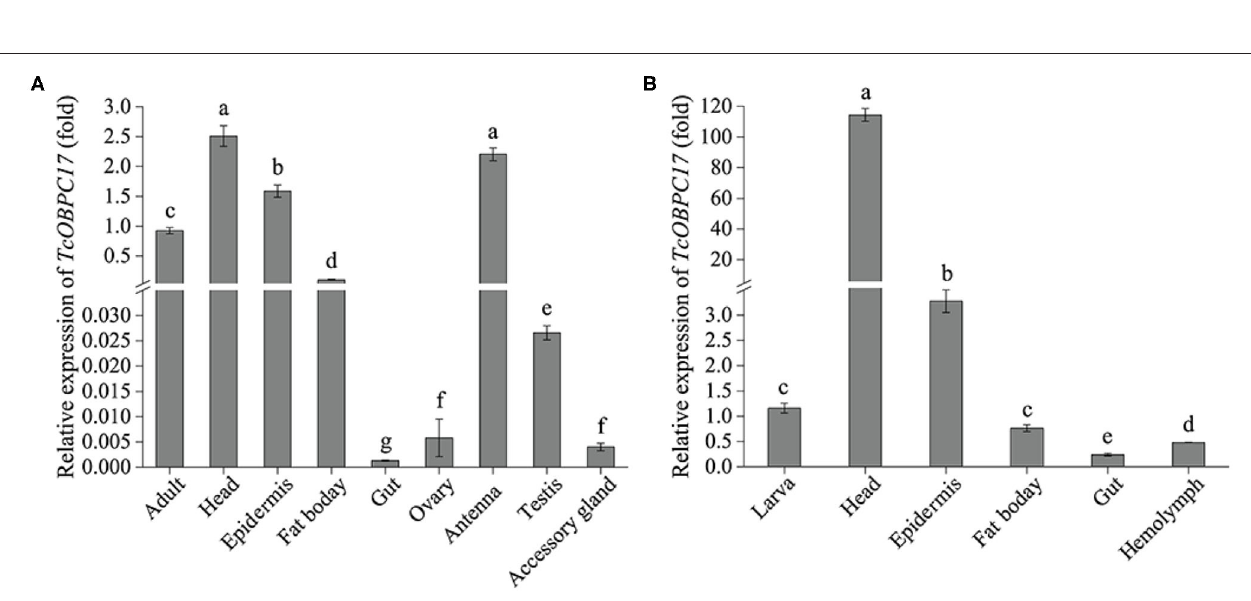
Frontiers in Toxicology |